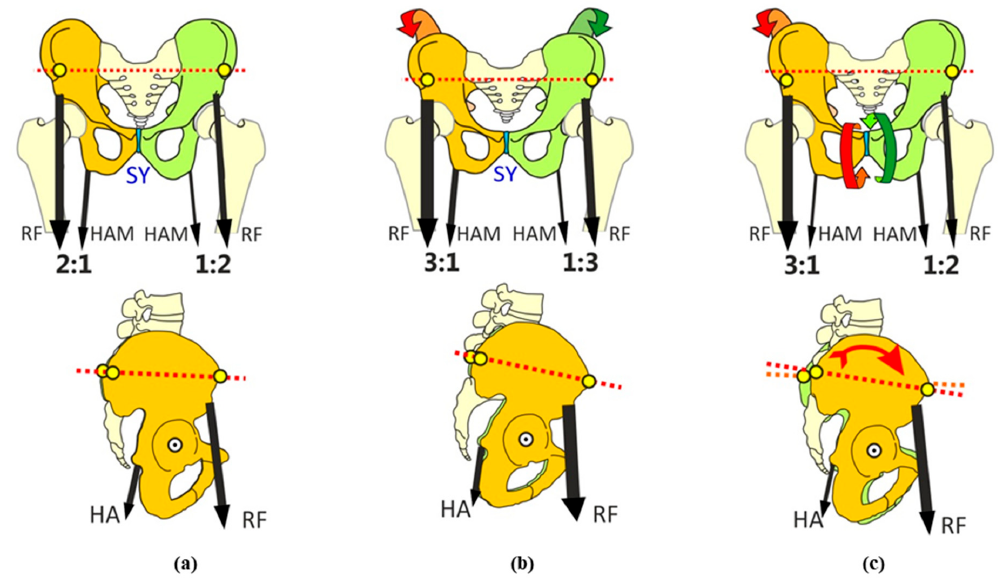
Figure 5. Model of the development of pelvic torsion owing to muscular torque ratios between rectus femoris (RF) and hamstrings (HA). Arrow thickness represents traction force. ( a ) Different torque ratios right and left, but identical anterior–posterior torque ratio (2:1): pelvis neutral. ( b ) Increased anterior–posterior torque ratio (3:1): anterior pelvic tilt. ( c ) Different torque ratios left and right: unilateral pelvic tilt and pelvic torsion. SY = pubic symphysis. Only a few studies focus on the three-dimensional movement of the hemi-pelvises against each other and the sacrum. Becker et al. describe physiological, rotatory movements of one degree in the pubic symphysis [28]. Strain caused by standing on one leg results in relative vertical shearing stress and tensile stress on the stabilizing sacroiliac joints, as well as in vertical shearing and pressure strain